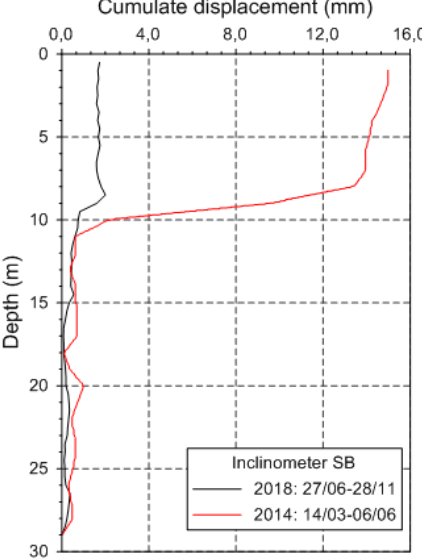
Figure 12. Comparison between displacements recorded in 2014 and in 2018 in the same borehole.